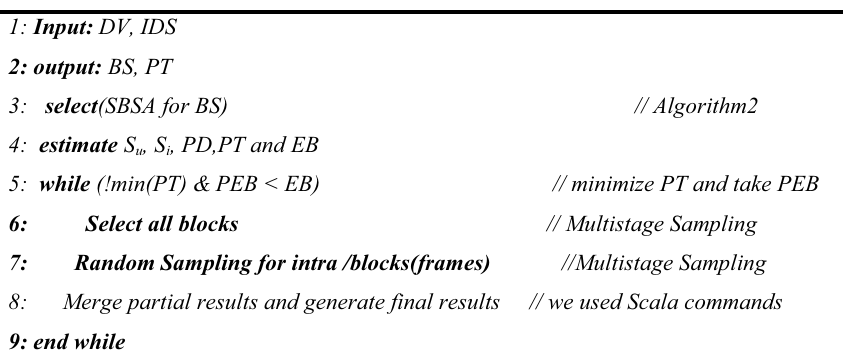
Algorithm1. Deision1(skew-aware